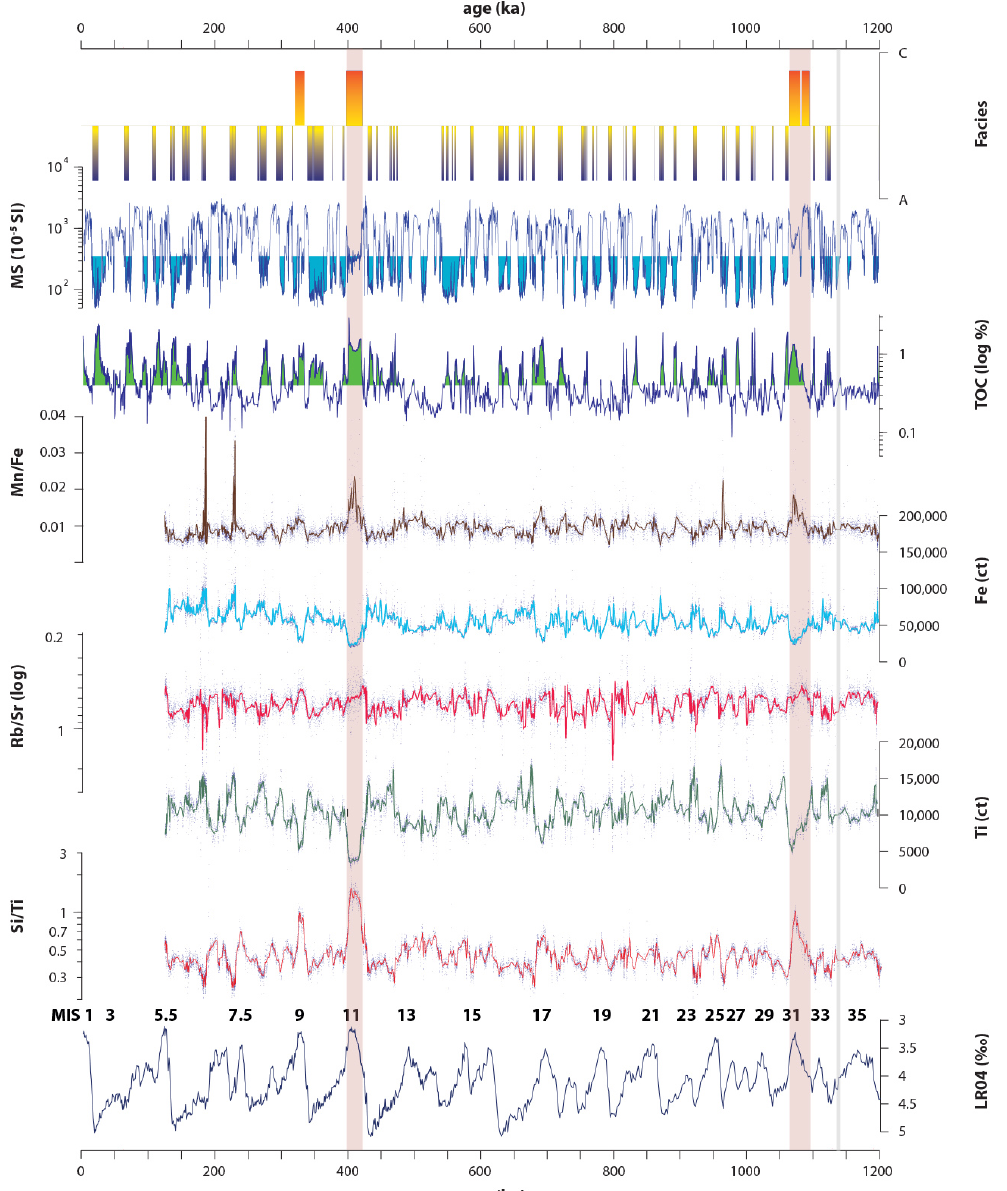
Figure 4. Expanded section of the past 1.2Myr showing XRF-scanning-derived Si/Ti ratios, Ti intensities, Rb/Sr ratios, Fe intensities, and Mn/Fe ratios as well as magnetic susceptibility (MS; Nowaczyk et al., 2013), total organic carbon (TOC), and the occurrence of sediment facies A and C in the sediment record from Lake El’gygytgyn vs. age compared with the LR04 global marine isotope stack. XRF data are plotted as raw data (blue dots) and 101-point weighted running average (colored lines). “Super-interglacials” MIS 31 and 11.3 at Lake El’gygytgyn are highlighted with red bars. Gaps in the record are shaded with grey bars. Please not the logarithmic scaling of the TOC and MS scales, and the inverse logarithmic scaling of the Rb/Sr